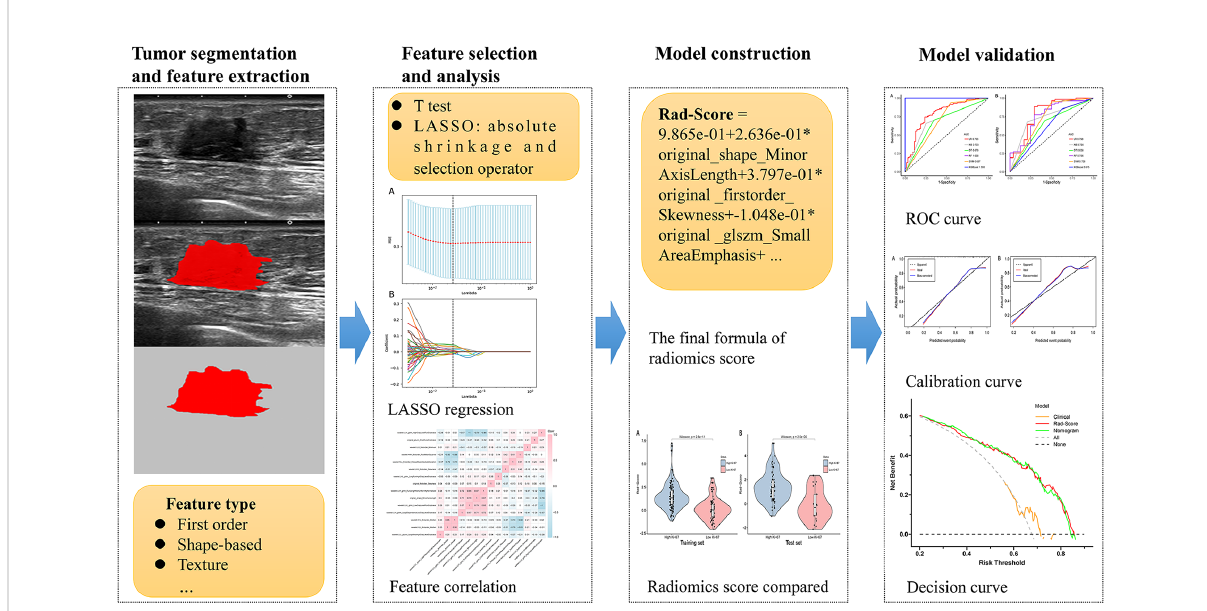
FIGURE 1 Flowchart of the processing step using the radiomics method for predicting the Ki-67 status. * means